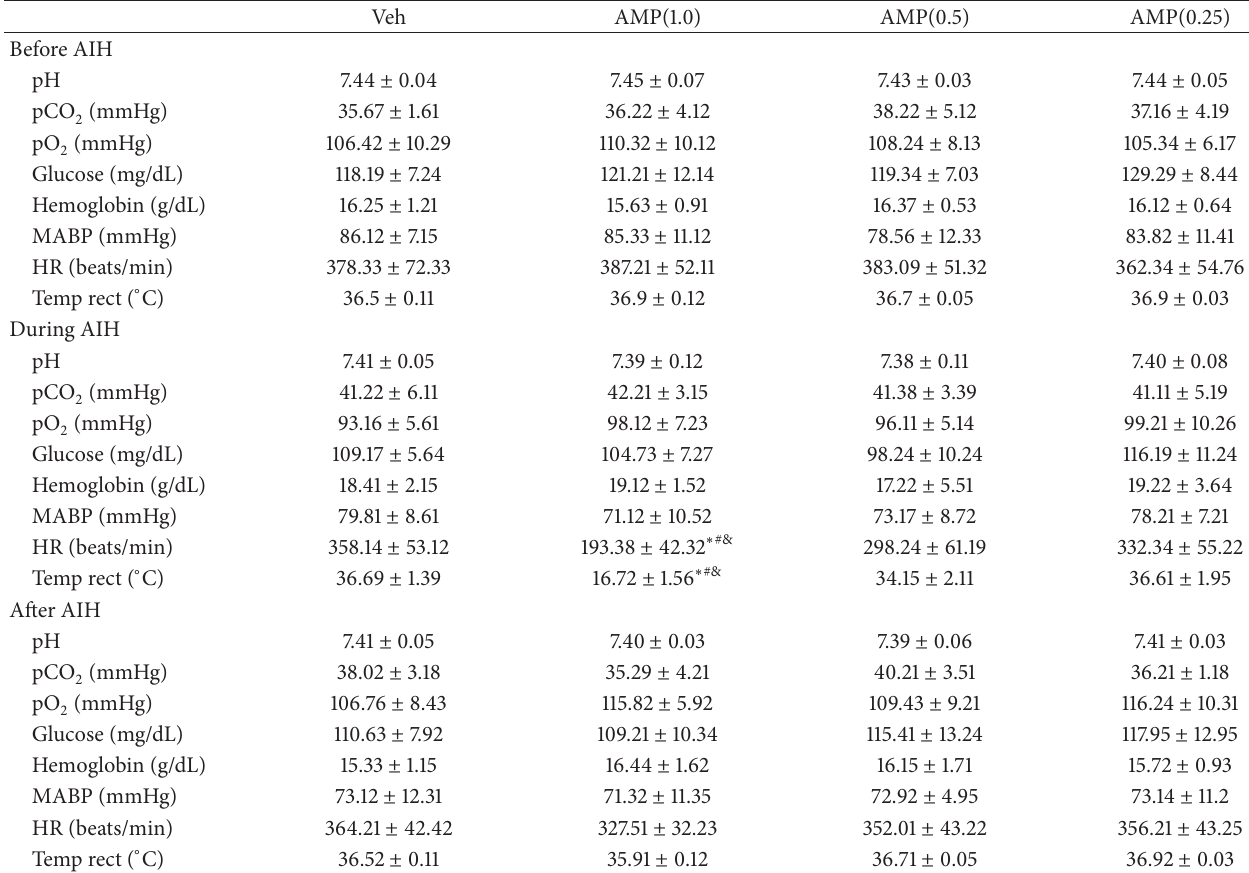
Table 1: 5 󸀠 -AMP reduces body temperature, heart rate and blood